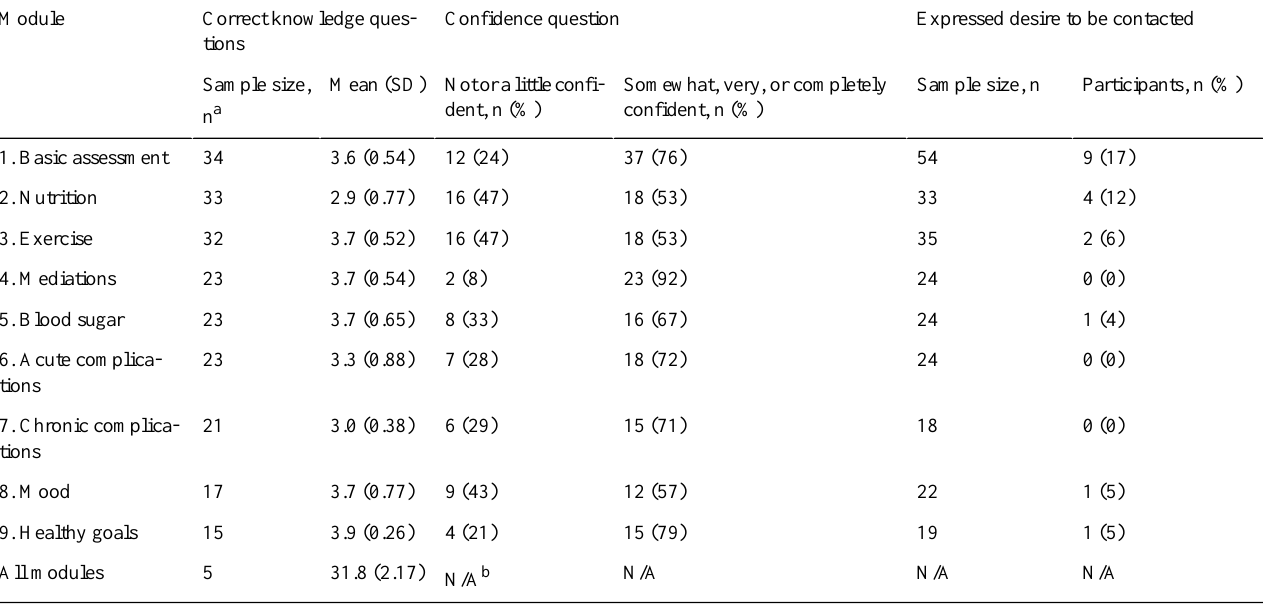
Table 3. Summaries of knowledge assessment, confidence question, and desire to be contacted for each Diabetes Engagement and Activation Platform